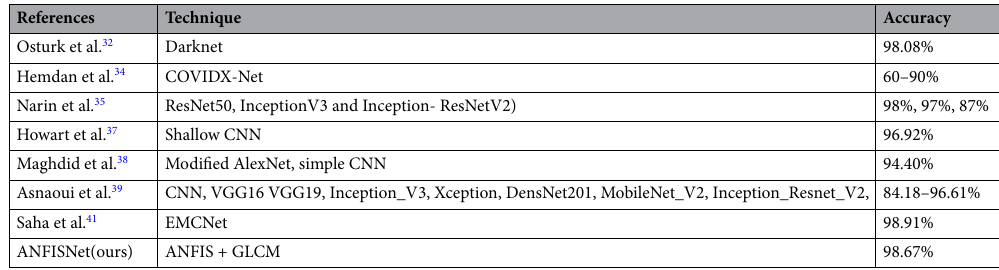
Table 2. Comparison of the proposed method with the state-of-the-art techniques for binary classification of